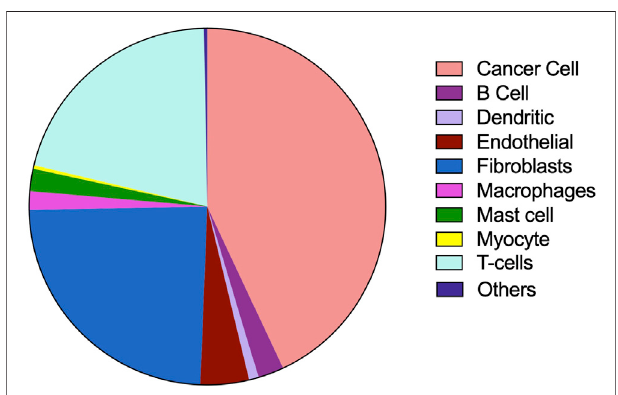
FIGURE 12 | Composition of different cell types in tumor microenvironment analysed using the dataset GSE103322. The percentage composition of cancer cells, B cells, dendritic cells, endothelial cells, fi broblasts, macrophages, mast cells, myocytes, T cells and other cells are visualized using pie-chart